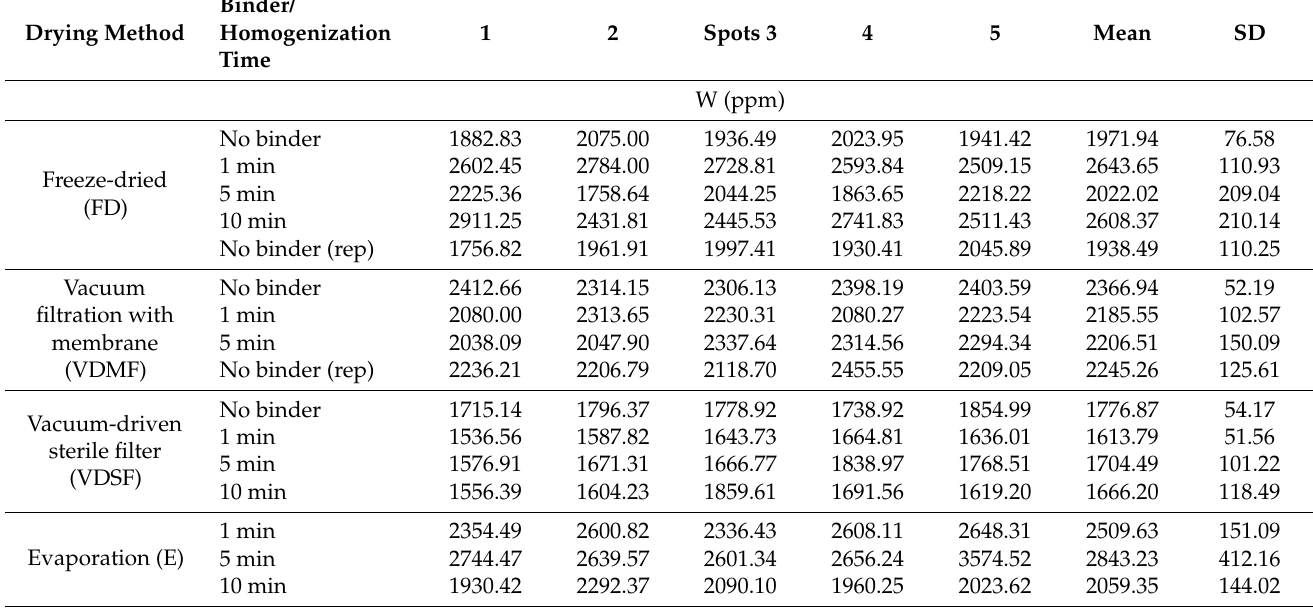
Table 3. Summary of W concentrations (ppm) of the Mittersil ore pellets obtained by LA-ICP-MS spot analysis following pellet production using different drying techniques. The values are based on data normalized to SiO 2 as an internal standard. SD = standard deviation; rep = repeated analytical run.